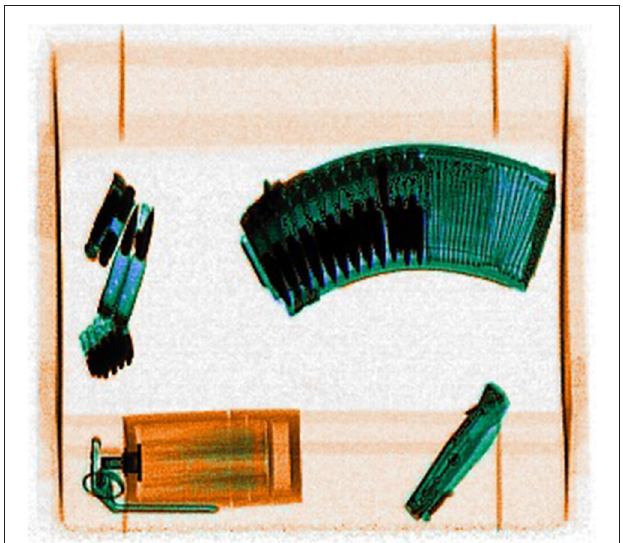
FIGURE 2 | Example threat display presented in the familiarization phase of the x-ray screening